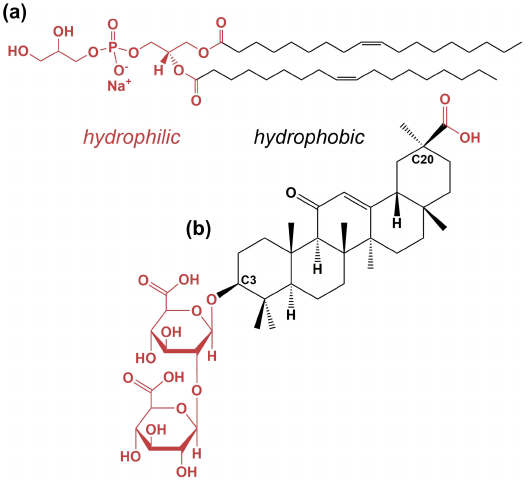
Figure 1. Molecular structures of ( a ) the phospholipid 1,2-dioleoyl- sn -glycero-3-phospho-rac-(1’- glycerol) (DOPG) and, ( b ) the saponin glycyrrhizin. Hydrophilic molecular parts are shown in red, hydrophobic ones in black. In this work, glycyrrhizin is present in the fully deprotonated